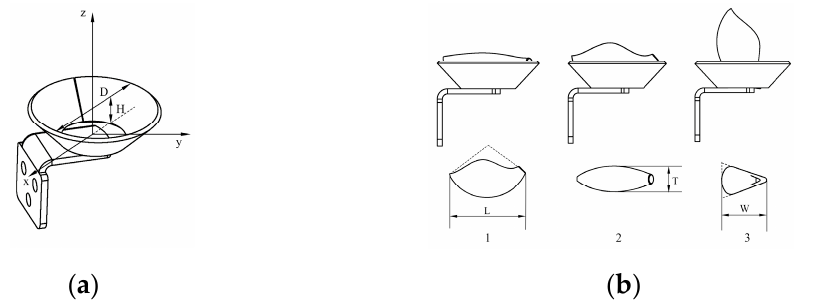
Figure 3. Seed-picking spoon size and garlic stance: ( a ) structure of the seed scoop; ( b ) garlic stance and vertical projection.